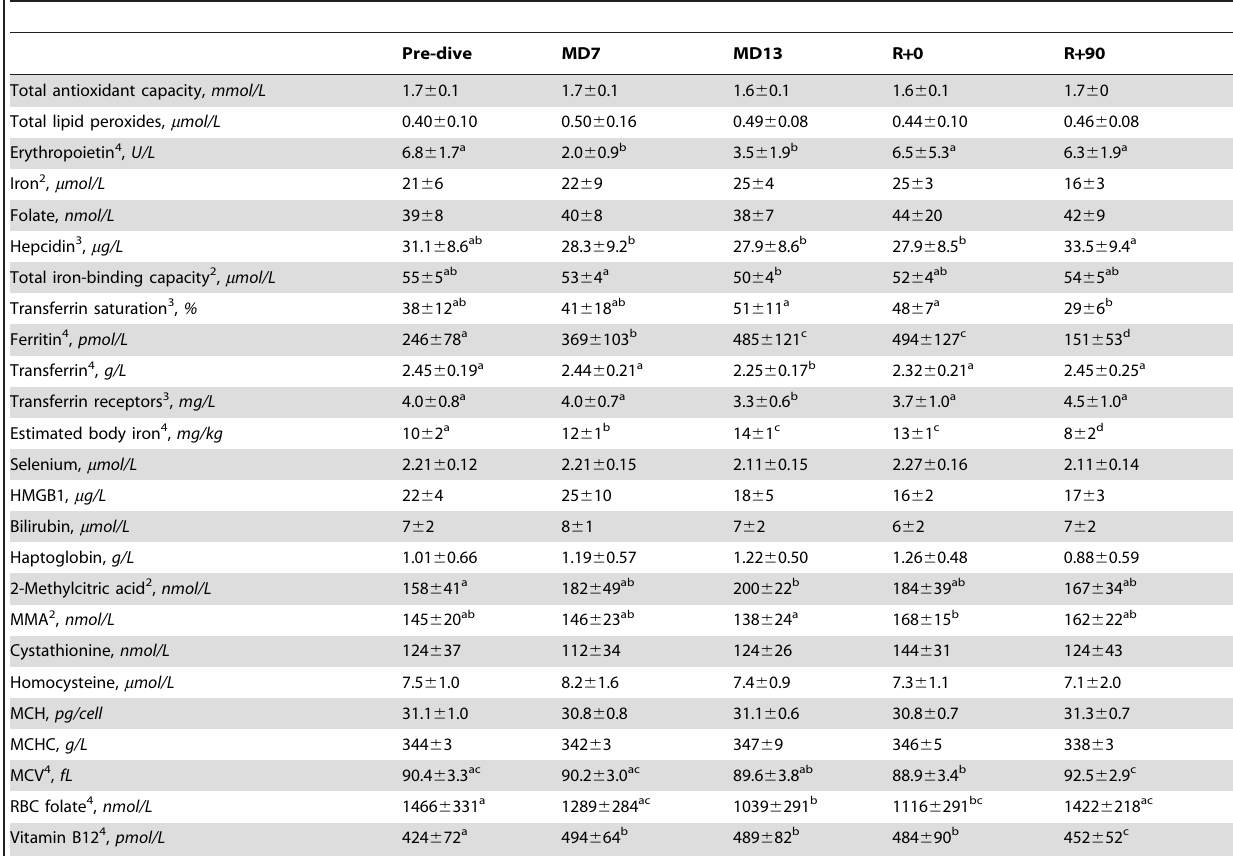
Table 2. Serum variables related to oxidative damage, iron status, DNA damage, and vitamin metabolism before, during, and after a 13-d saturation dive in humans 1